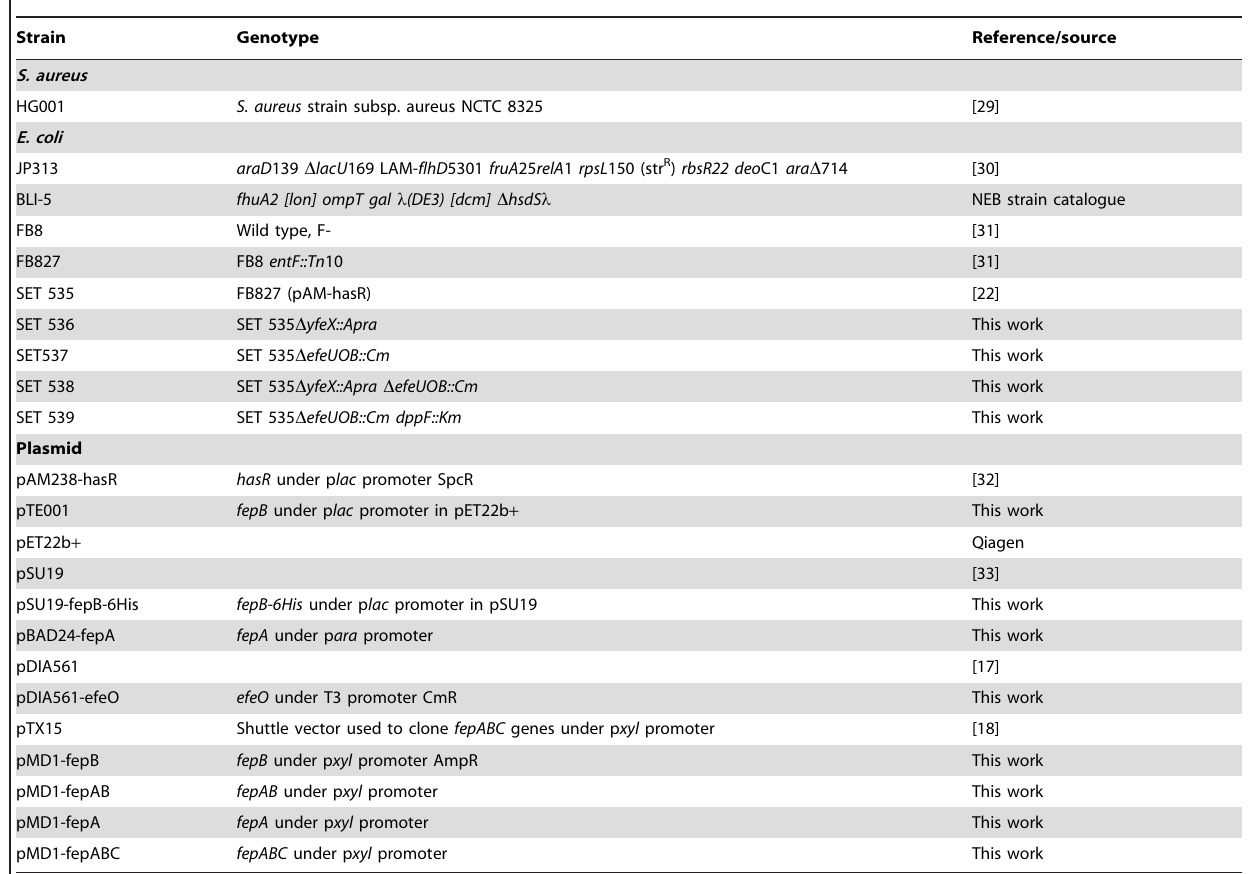
Table 1. Bacterial strains and